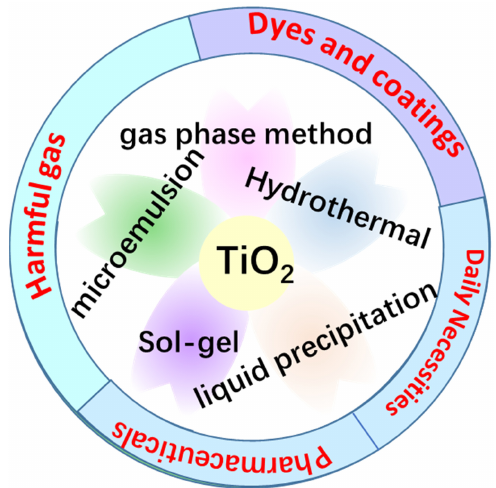
Figure 1. TiO 2 preparation methods and applications.